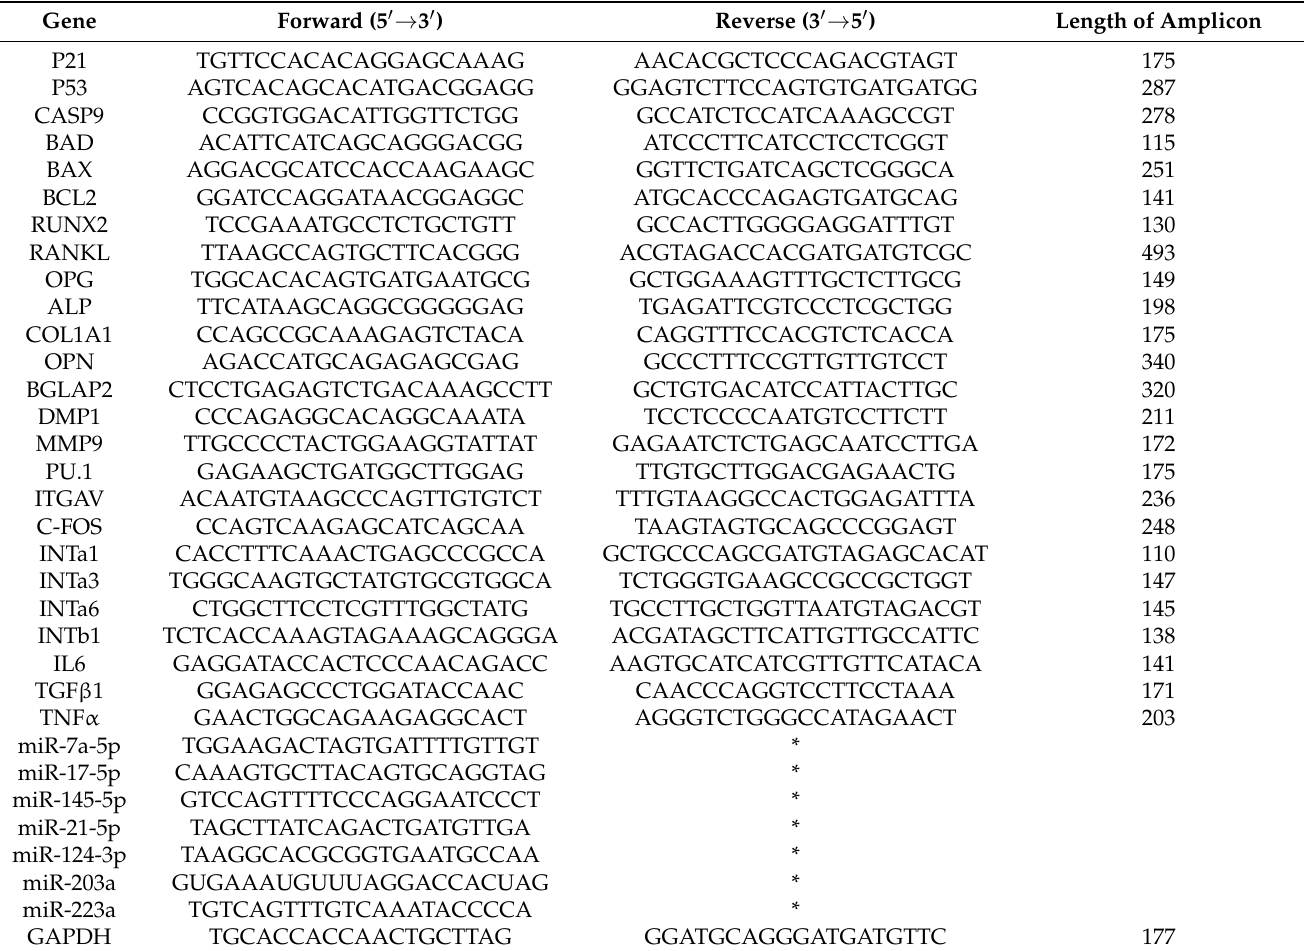
Table 1. Sequences of primers used in the actual